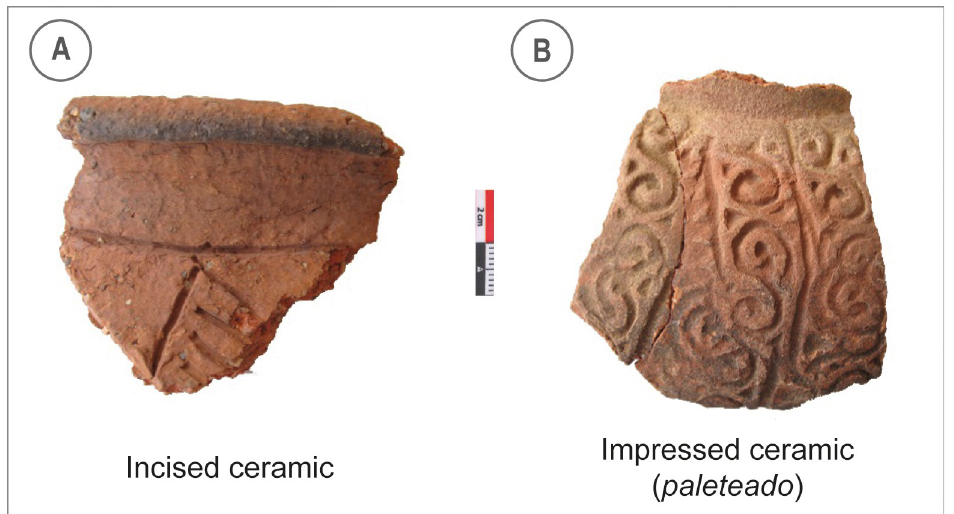
Fig 4. Ceramic shards from area A.41. A. A fragment of incised ceramic, common in the lower part of Huaca Grande archaeological sequence (layers 43 to 33). B. A fragment of paleteado ceramic, from the more recent occupation layers of Huaca Grande (layers 8 to A).